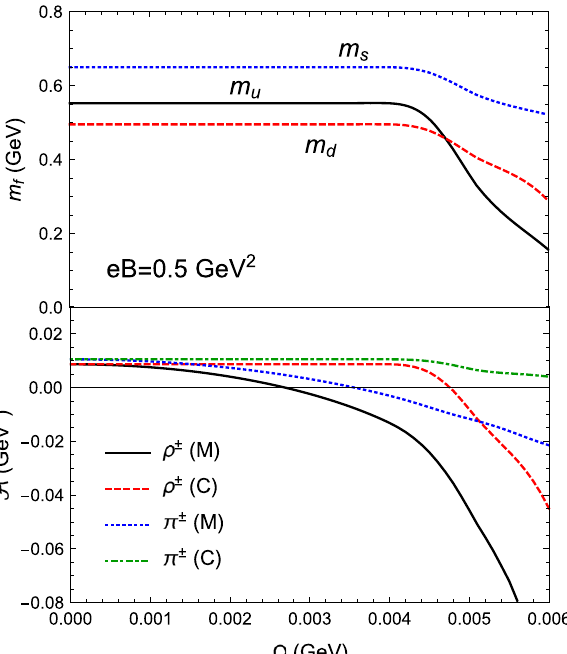
Fig. 4 The evolutions of the dynamical quark masses m f (upper panel) and the quadratic GL expansion coefficients A (lower panel) with the angular velocity (cid:5) at the magnetic field eB = 1 . 5 GeV 2 . The conven- tions are the same as in Fig.